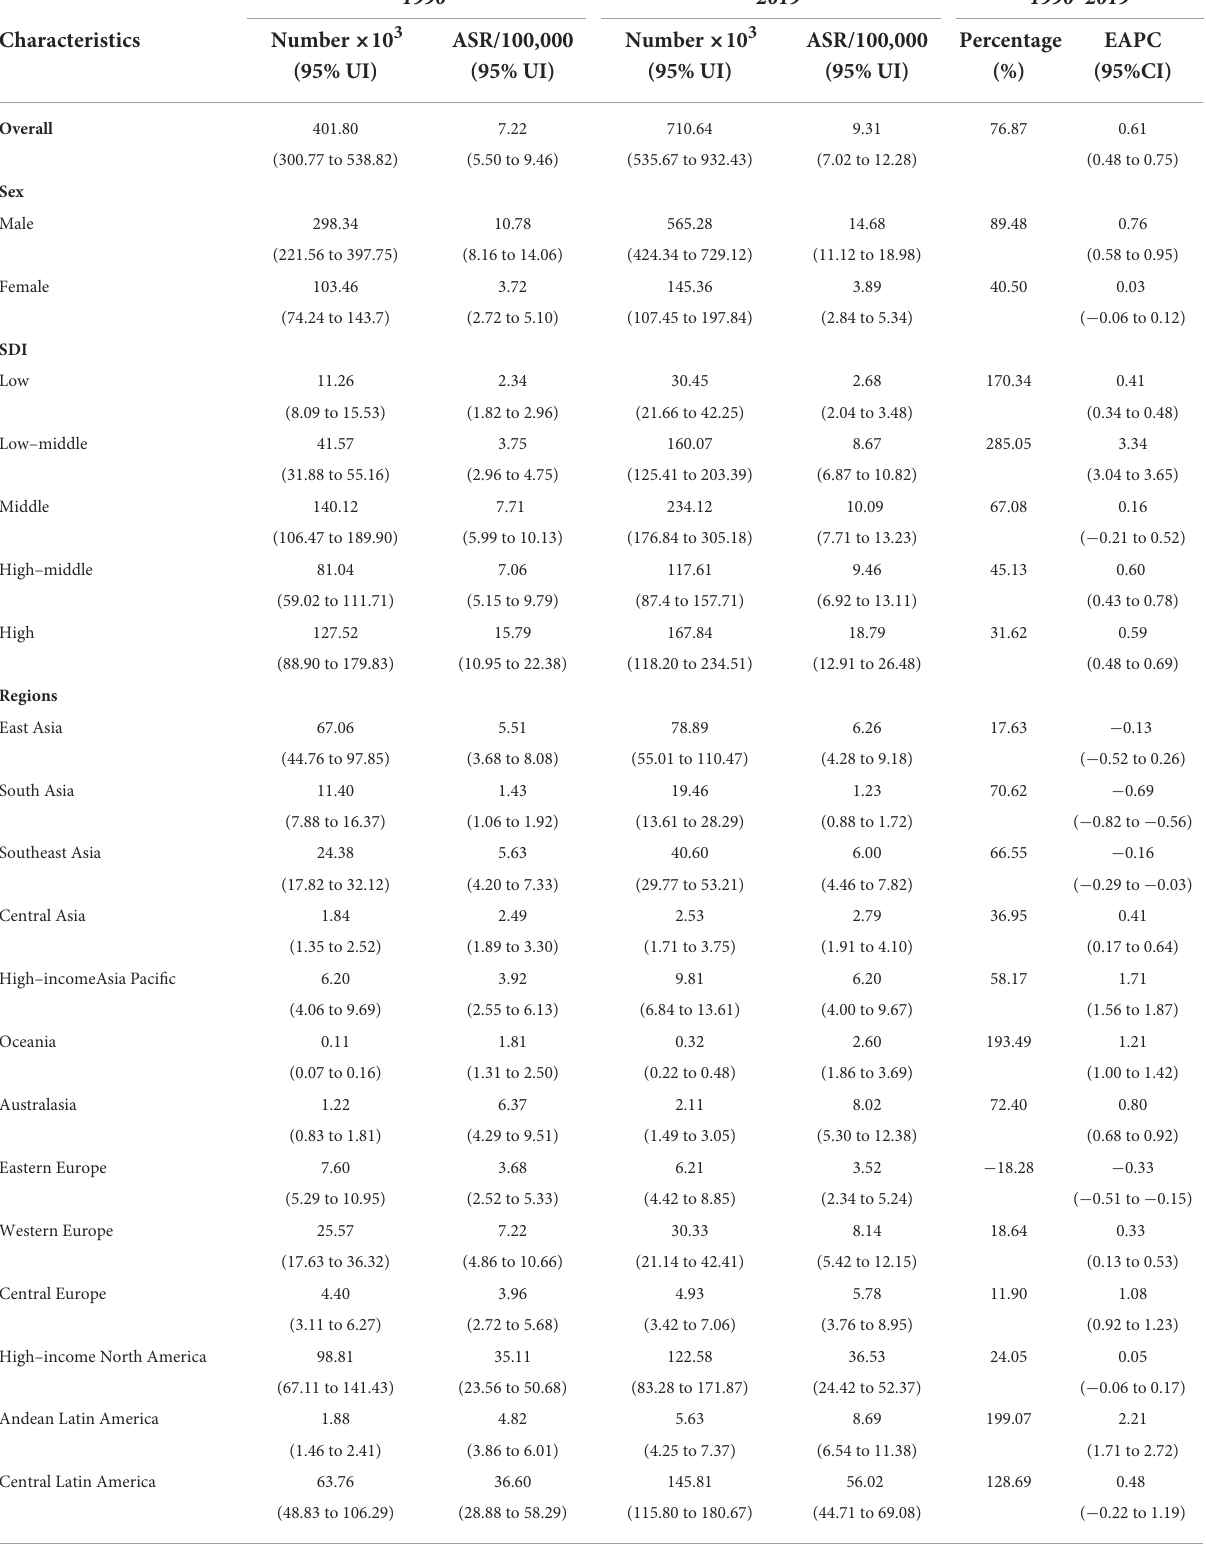
TABLE 1 Global incident burden and trends of physical violence by firearm in sexes, SDI areas, and regions,